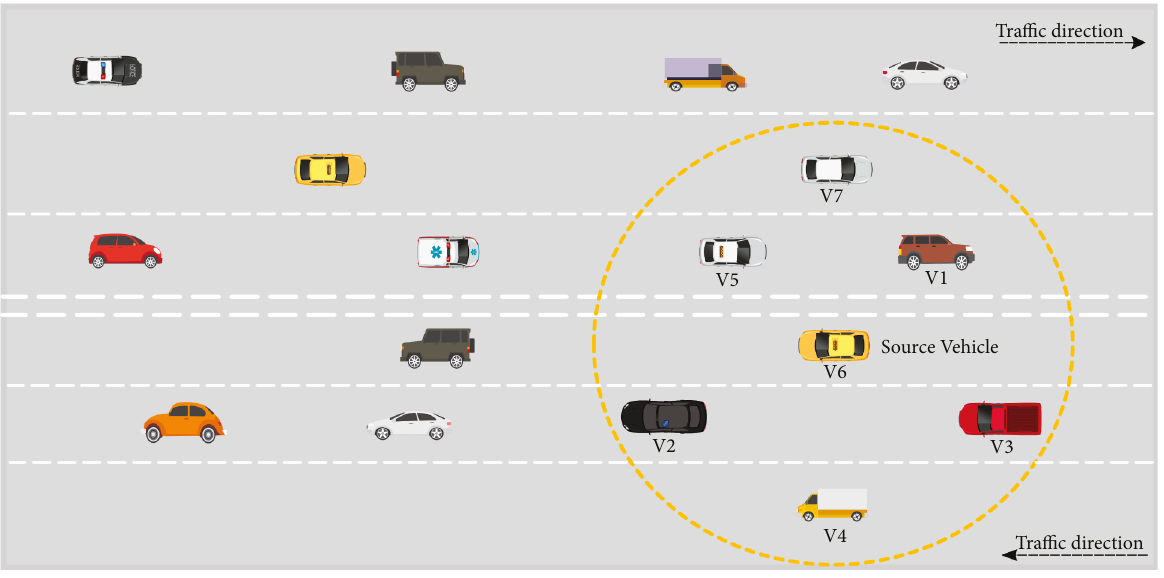
Figure 1: Proposed scenario. Table 3: the 9-point quantitative scale.